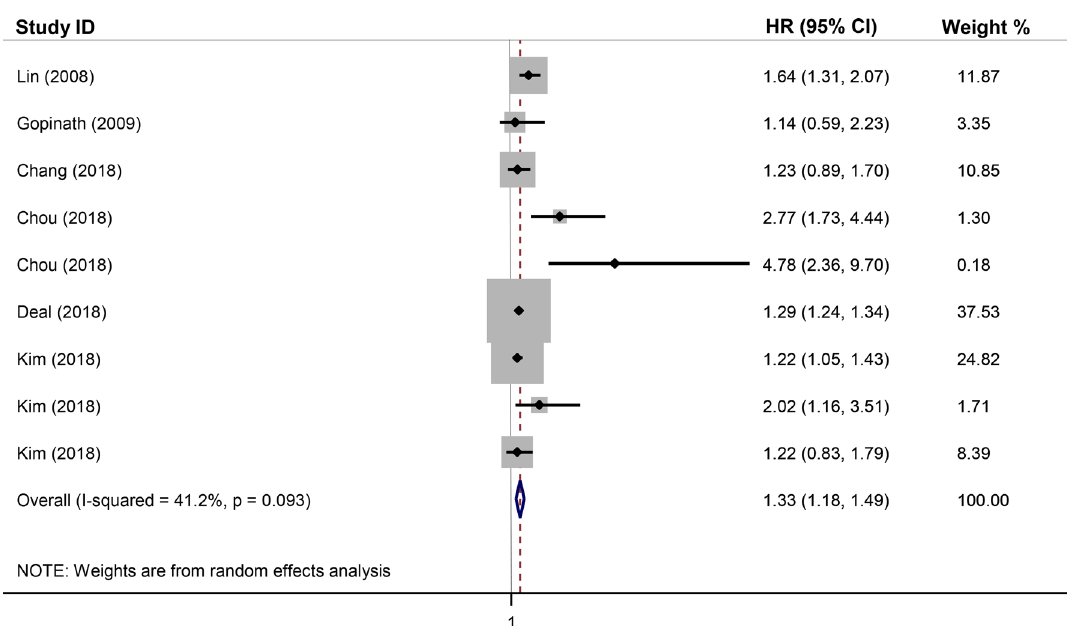
Figure 2. Forest plot for the association between sensorineural hearing loss (SNHL) and the incidence of stroke in the unadjusted model. HR adjusted hazard ratio, CI confidence interval.